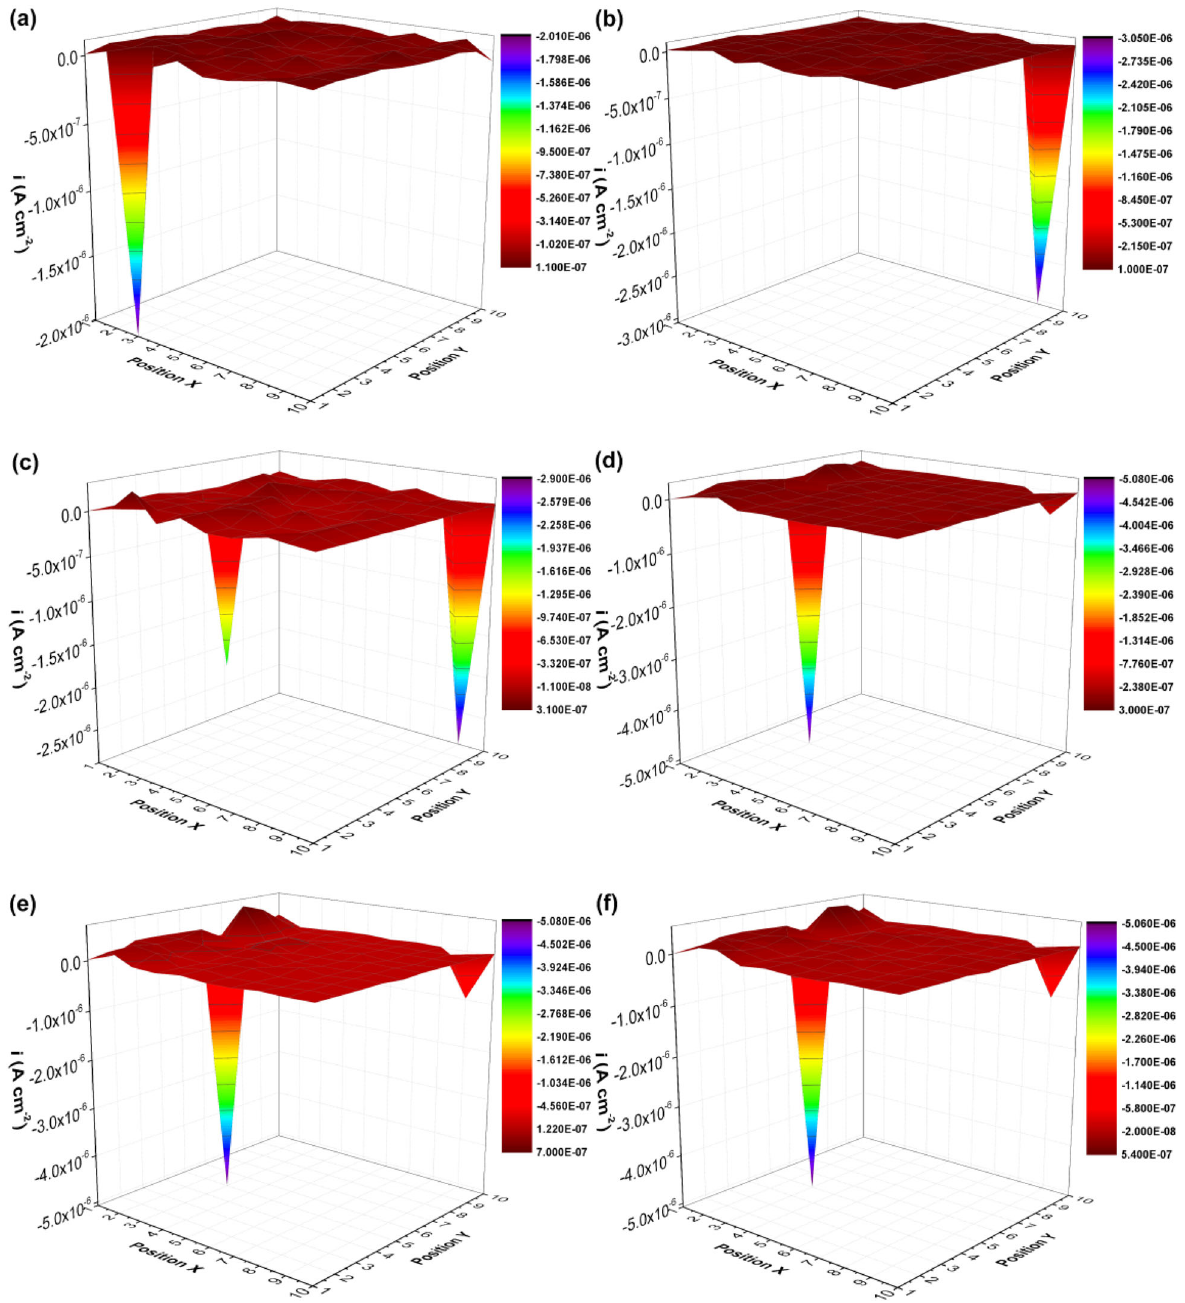
Fig. 7 The changes of distributions of galvanic current density for the abiotic control WBE with time. a 1 d, b 2 d, c 4 d, d 7 d, e 10 d, f 14